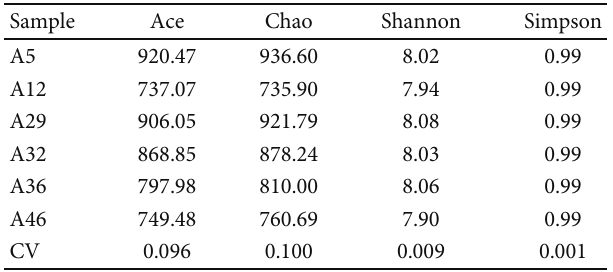
Table 1: Alpha diversity among individual liver